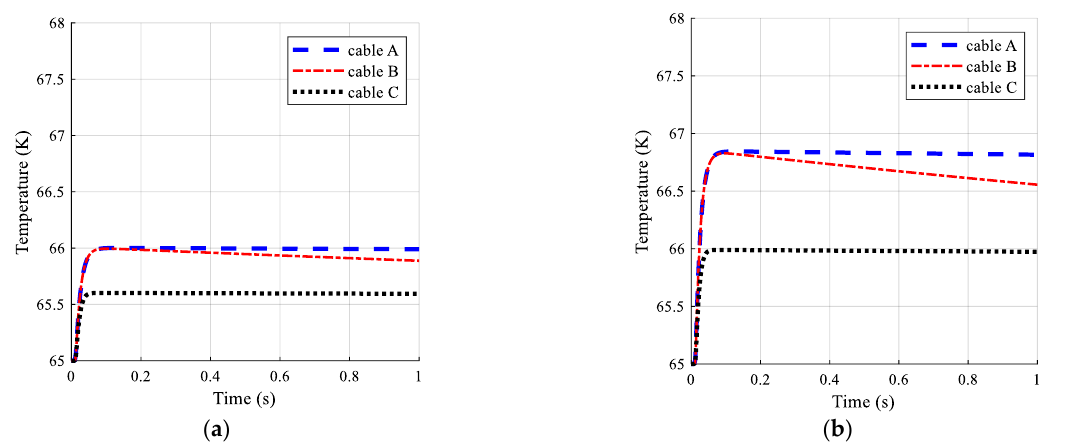
Figure 8. Temperature of the former layer in each of three HTS cables, ( a ) copper former, ( b ) alumi- num former. former.